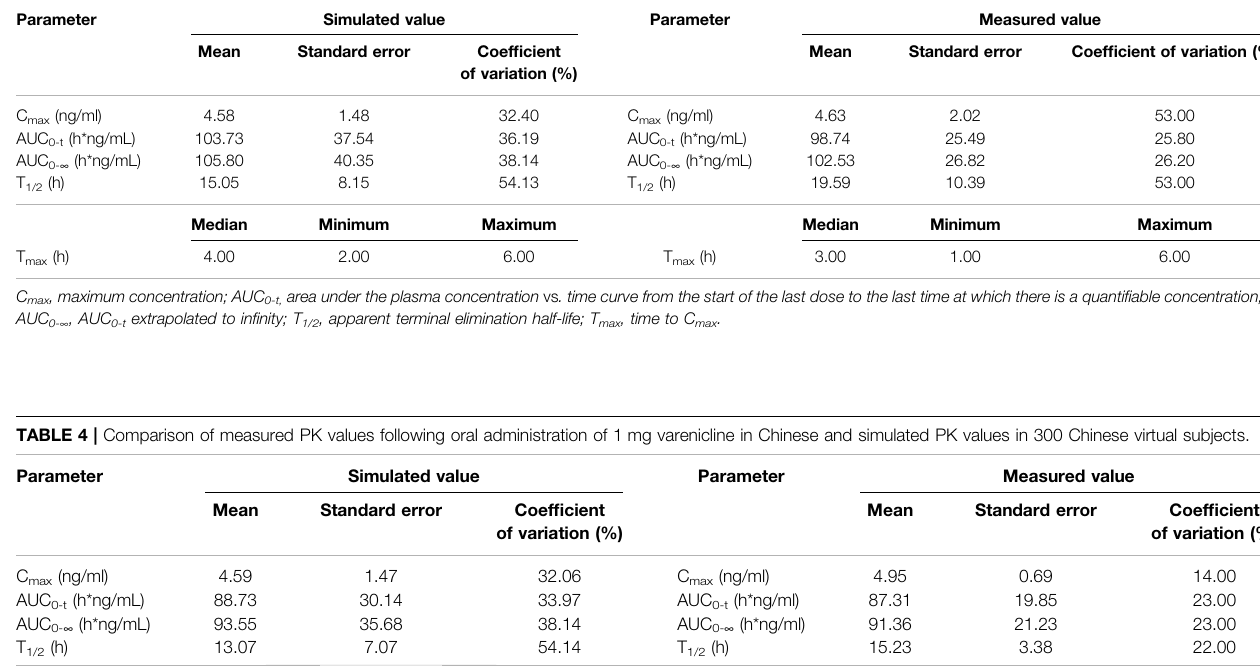
Median Minimum Maximum Median Minimum Maximum T max (h) C max , maximum concentration; AUC 0-t, area under the plasma concentration vs . time curve from the start of the last dose to the last time at which there is a quanti fi able concentration; AUC 0- ∞ , AUC 0-t extrapolated to in fi nity; T 1/2 , apparent terminal elimination half-life, T max , time to C max